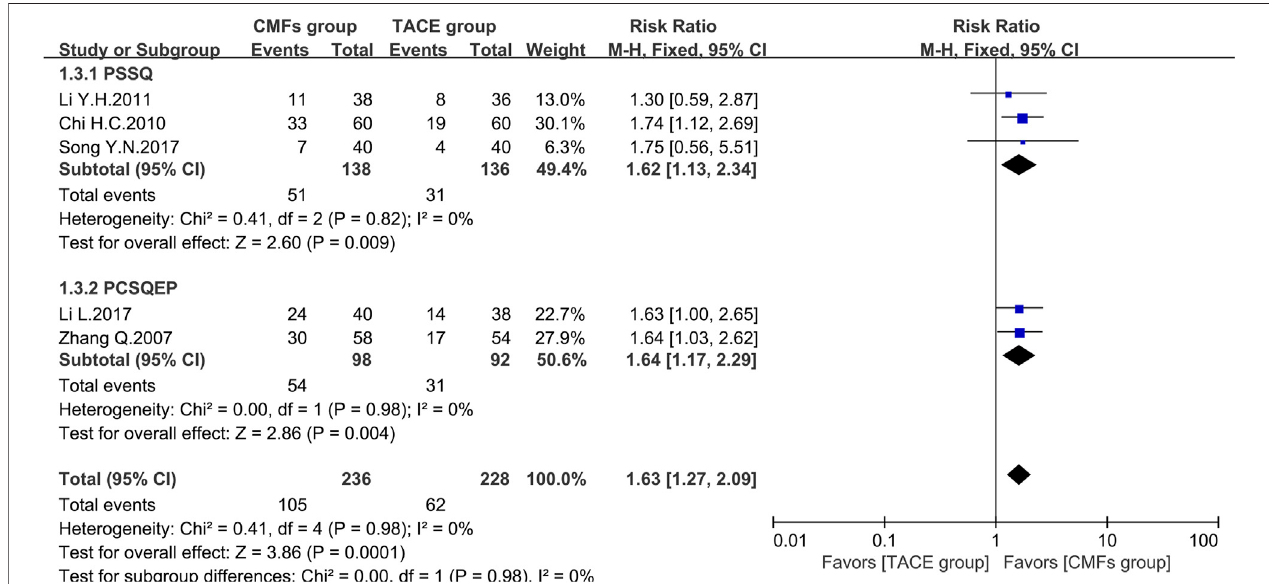
FIGURE 4 | Effect of CMFs group versus TACE group on 2-year survival, including a comparison between PSSQ and PCSQEP in the subgroup.